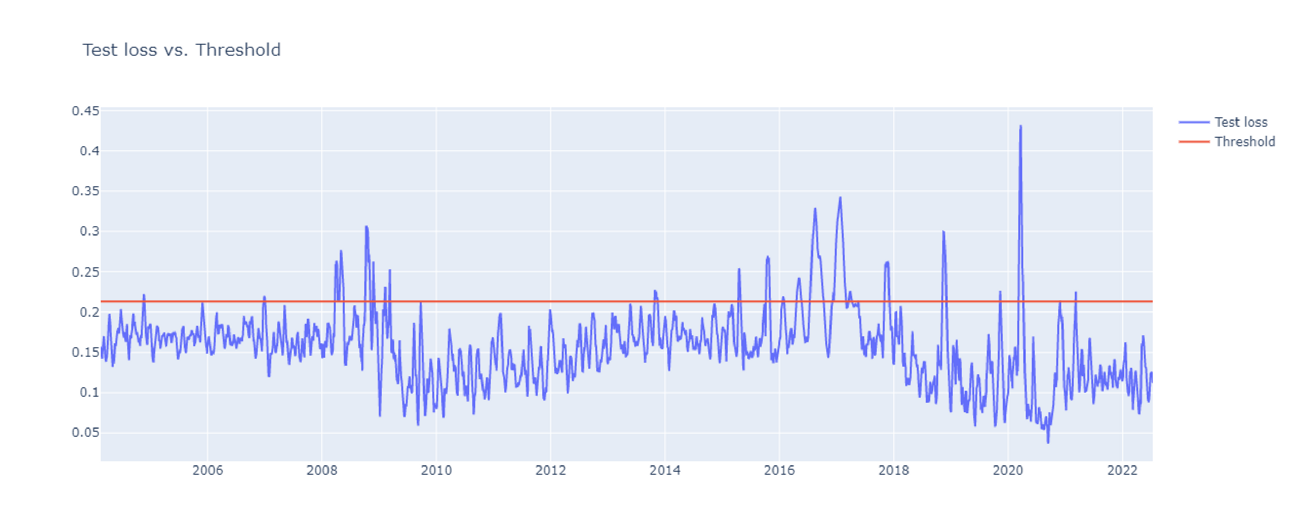
Figure 8. The test loss and training threshold from the LSTM auto-encoder.